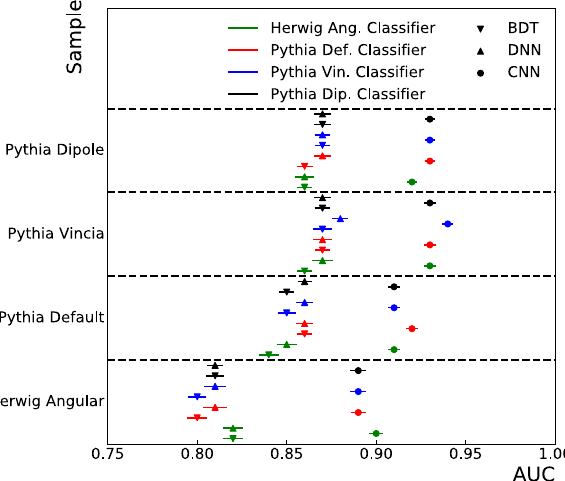
Fig. 5 The performance of classifiers as quantified by the AUC when training on a given PSMC (color) and testing on the PSMC specified on the vertical axis. The symbols represent the type of model (BDT, DNN, CNN). The error bars represent the standard deviation over the k